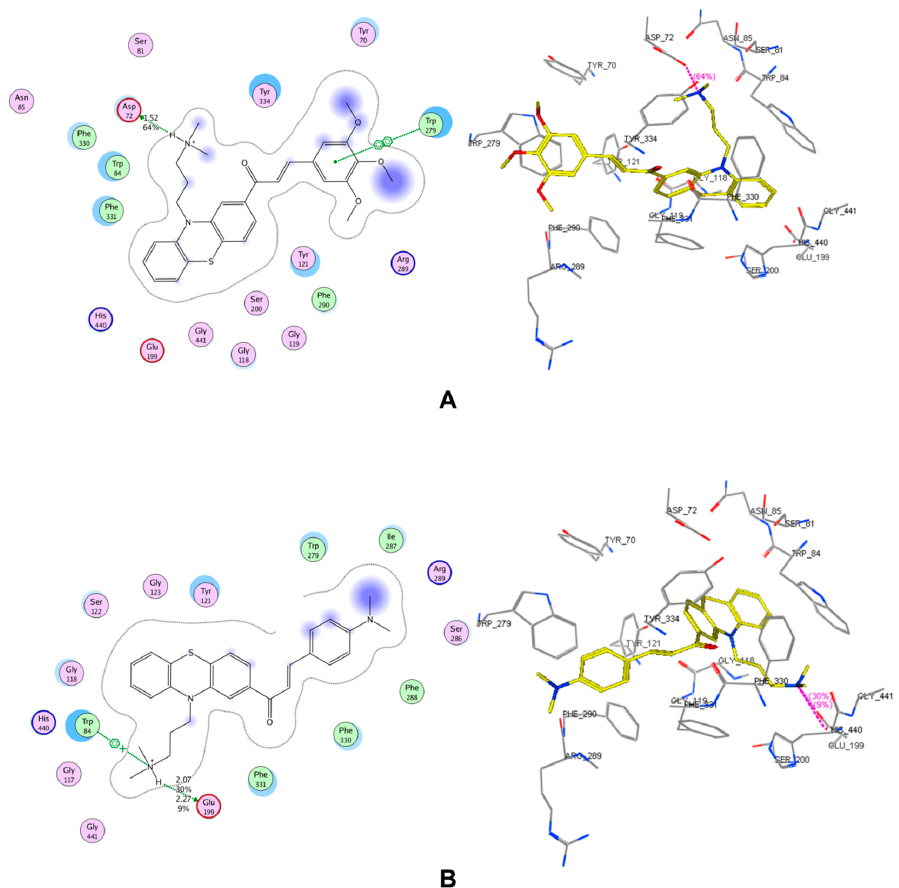
Figure 2. Interactions in the binding pocket of acetylcholinesterase (AChE, complex 1DX6) made by ( A ) AC4 (observed pIC 50 : 5.44 ± 0.08), ( B ) AC12 (observed pIC 50 : 5.96 ±